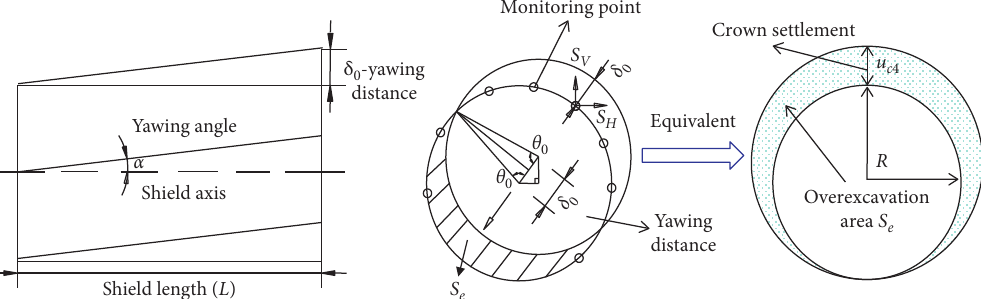
P P v and (b) P il > v . il <